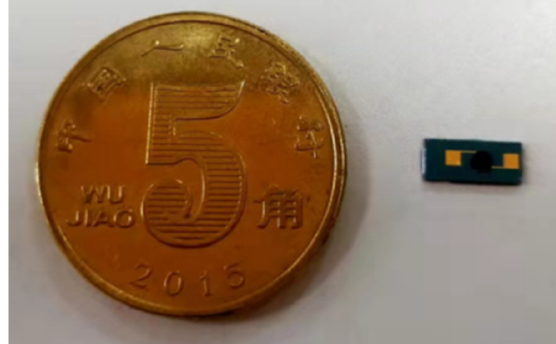
Figure 4. The physical diagram of the sensor.